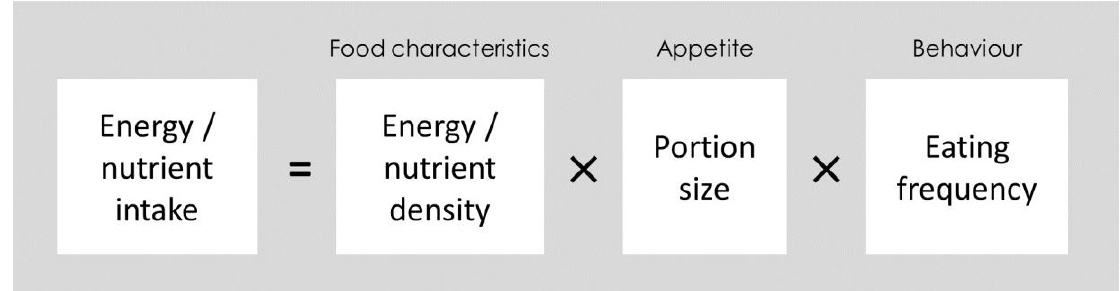
Figure 1. A conceptual framework of how nuts may increase energy/nutrient intake by influencing energy/nutrient density, portion size, and eating behaviours, and subsequently aid in the reversal/prevention of undernutrition.